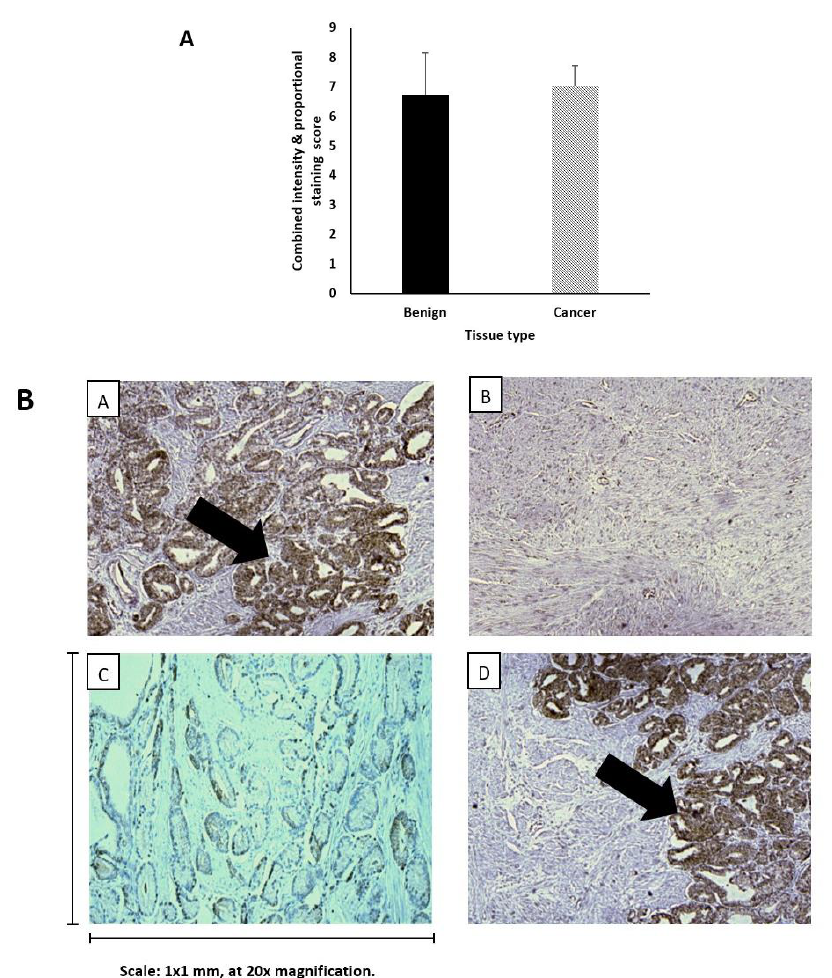
Figure 5. IHC staining of IGF-II peptide in benign and malignant prostate tumour tissue. ( A ) IHC staining of IGF-II peptide in FFPE prostate tumour tissue using the Ventana Benchmark Ultra machine. There were no was no significant differences in staining scores between malignant and benign. ( B) Patterns of IGF-II cytoplasmic IHC staining in paired tissue samples from 2 patients. Strong IGF-II peptide staining was observed in both cancer (A) and benign (D) tissue, as was weak staining (B/benign & C/cancer). The scale is 1 × 1 mm, at 20× magnification.